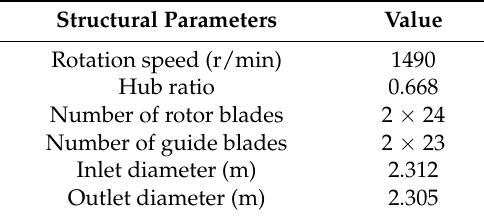
Figure 2. Diagram of the abnormal blade angle. 2.2. Mesh generation The meshes were generated in the GAMBIT software (GAMBIT 2.4.6, ANSYS, Canonsburg, PA, USA). To satisfy the flow requirements in the impeller, the grids were generated using a T-Grid type and Tet/Hybrid elements. The leading and trailing edges and the tip clearance of blades are covered with grids intensively using a size stretching function. The specific parameters of the size function are as follows, the type is meshed, the source and attachment entities are the surfaces of all blades and the impeller volume, the growth rate is 1.2, and the maximum size is 20 mm. The types of